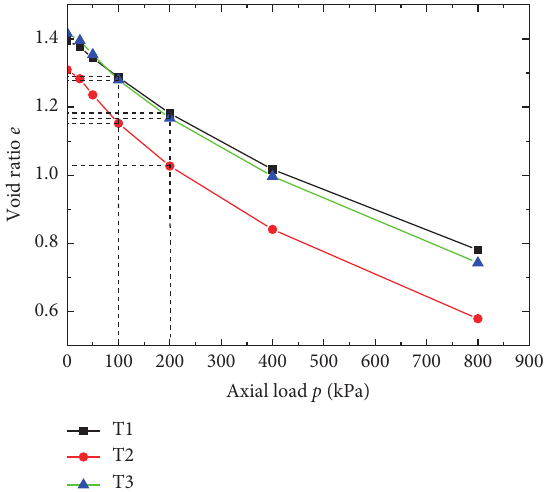
Figure 5: Results of CD tests and fitting curves of soil samples ( p ∼ q ).